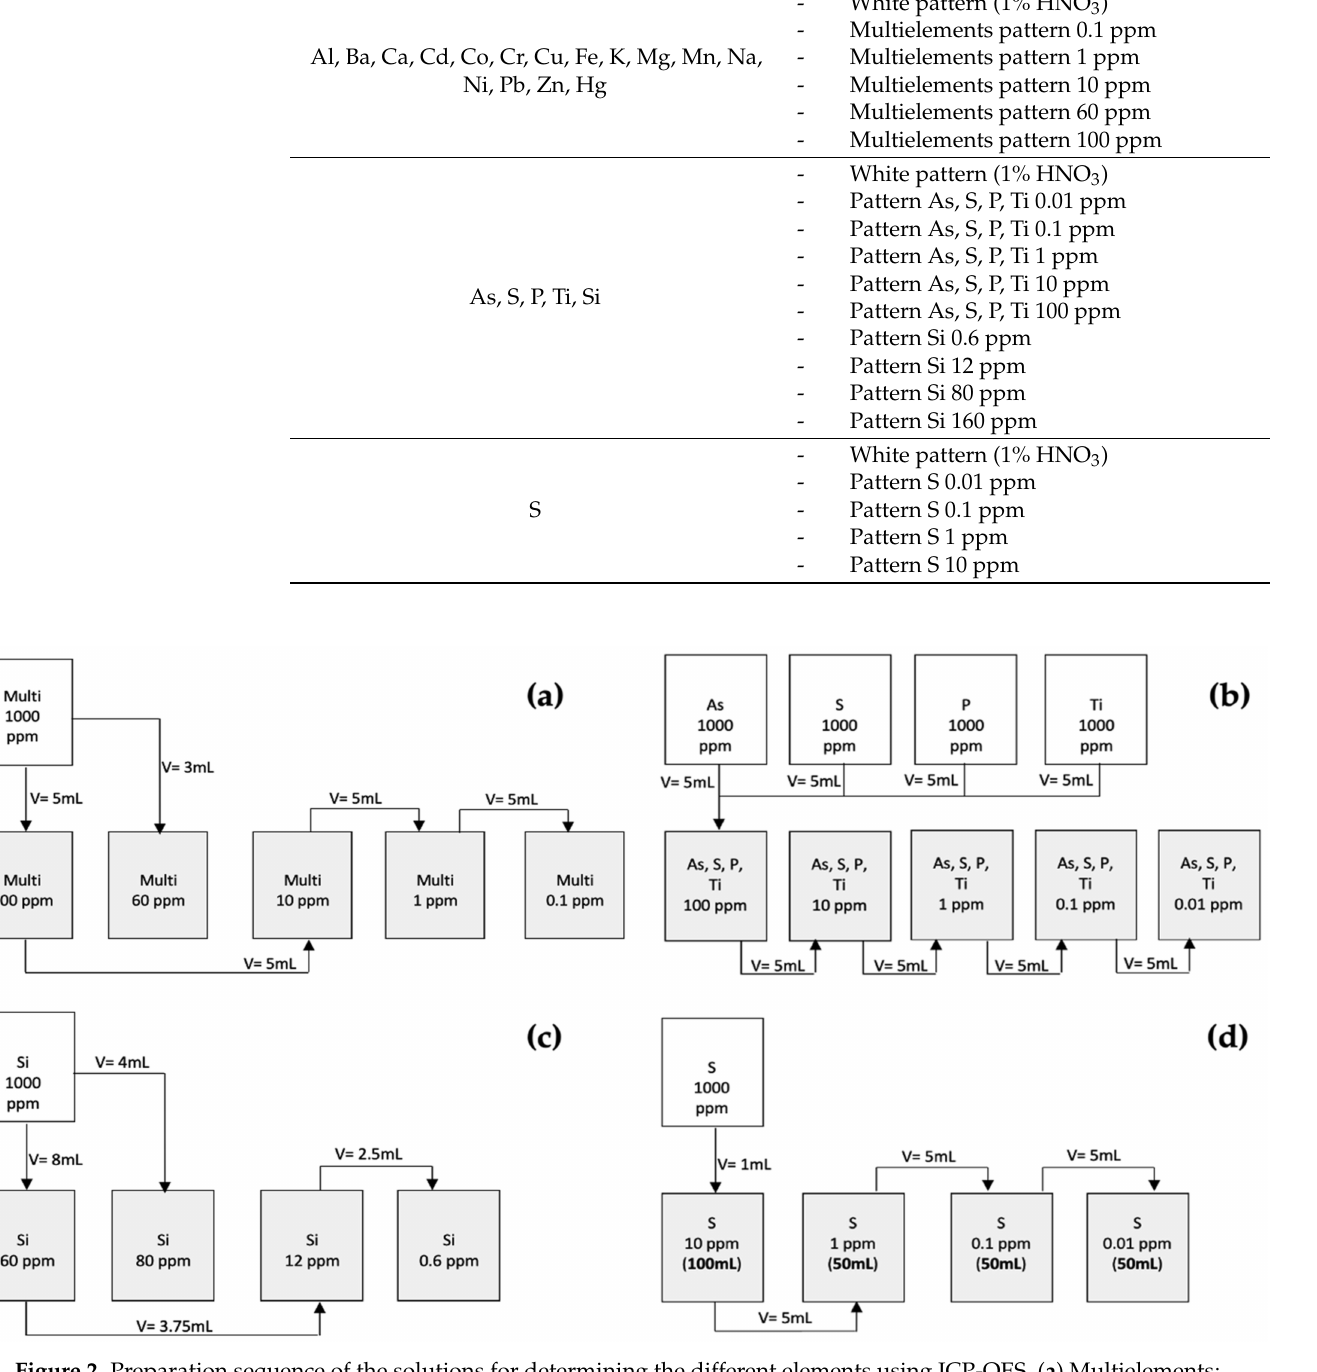
Figure 2. Preparation sequence of the solutions for determining the different elements using ICP-OES. ( a ) Multielements; ( b ) As, S, P, and Ti; ( c ) Si; and ( d )